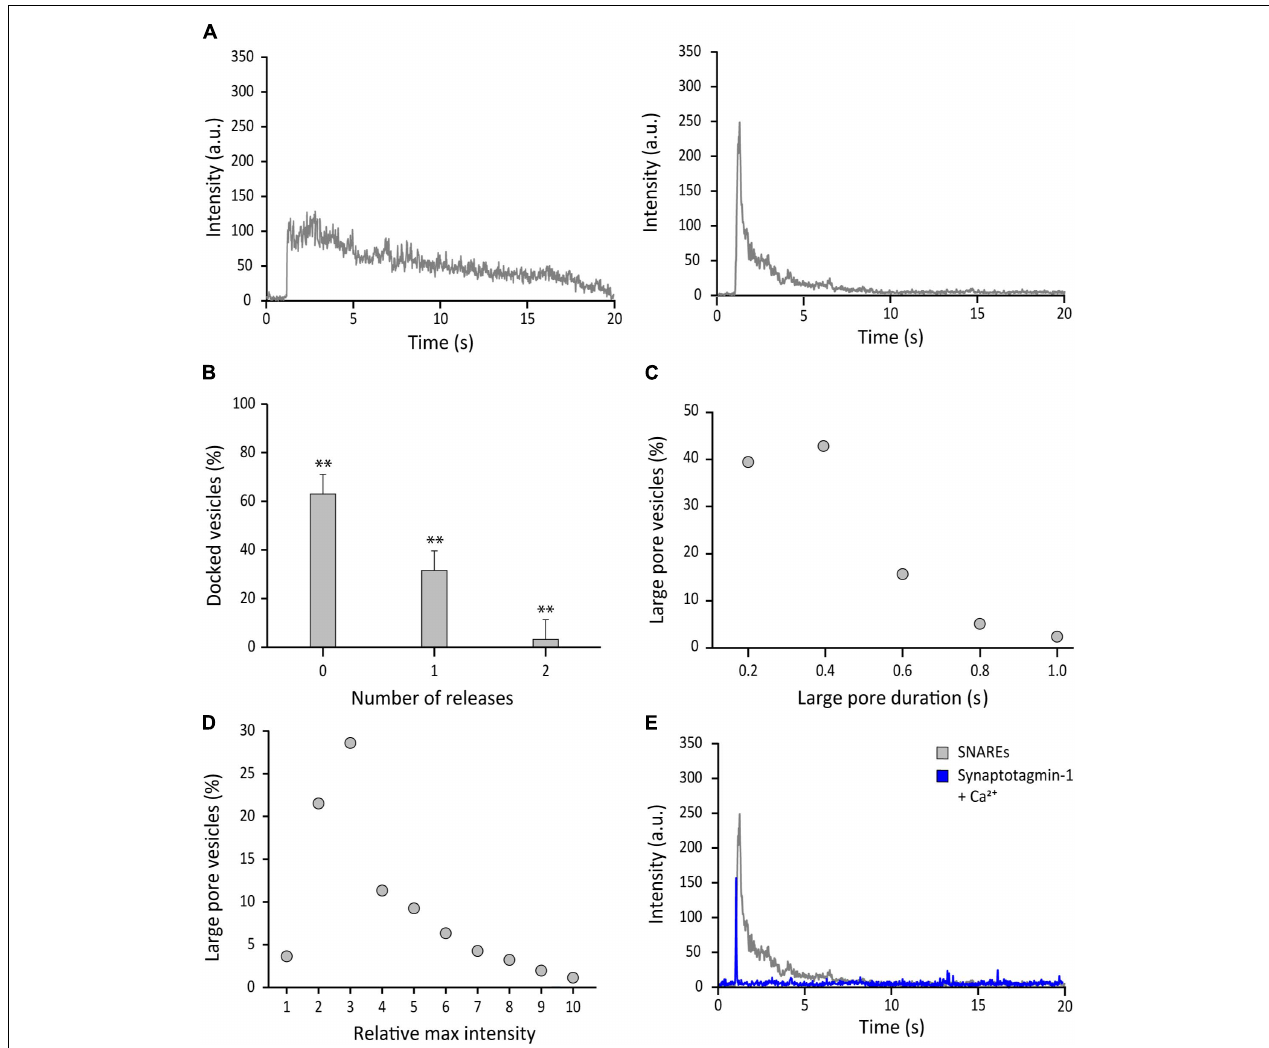
FIGURE 3 | SNAREs are inefficient at driving formation of the fusion pore larger than 6 nm. (A) Representative fluorescence time-traces of SNARE mediated fusion. Docked vesicles without apparent release (left) and with release (right) determined by 2D diffusion of fluorophores are shown. (B) Distribution of the number of large pore fusion events for individual docked vesicles. Total 4 independent measurements were analyzed for B–D. Error bars represent standard deviations from means. The data are shown as means ± SD. ∗∗ p < 0.01 by Student’s t- test; n = 3 independent experiments. (C) Distribution of duration of the large fusion pore, which is measured by the green part in Figure 2B . (D) Distribution of the relative maximum fluorescence intensity. The relative maximum fluorescence intensity of each event is calculated by dividing the maximum intensity caused by fusion pore expansion by the fluorescence intensity at the moment of vesicle docking. This is necessary because every vesicle has different number of content dyes. (E) Representative time traces of the content release event with SNAREs alone (gray) and with synaptotagmin-1 and 500 µ M Ca 2 + (blue). Synaptotagmin 1 and Ca 2 + were premixed before injection (Kim and Shin, 2017). The molar ratio of VAMP-2 vs. synaptotagmin 1 in the vesicle is 1:1. More than 100 time traces are collected and they all show the similar